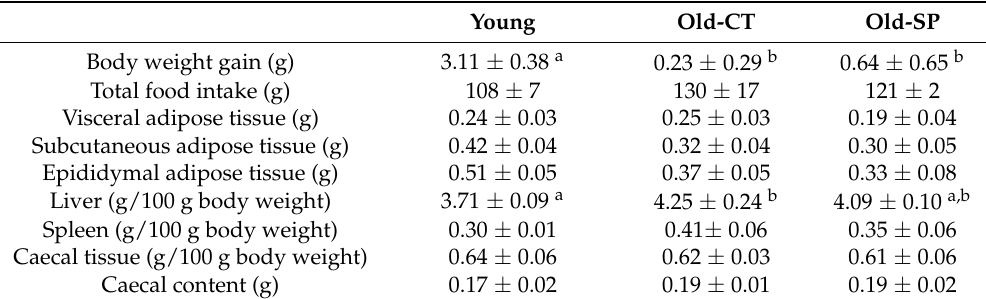
Table 1. Body weight gain, food intake, and organ